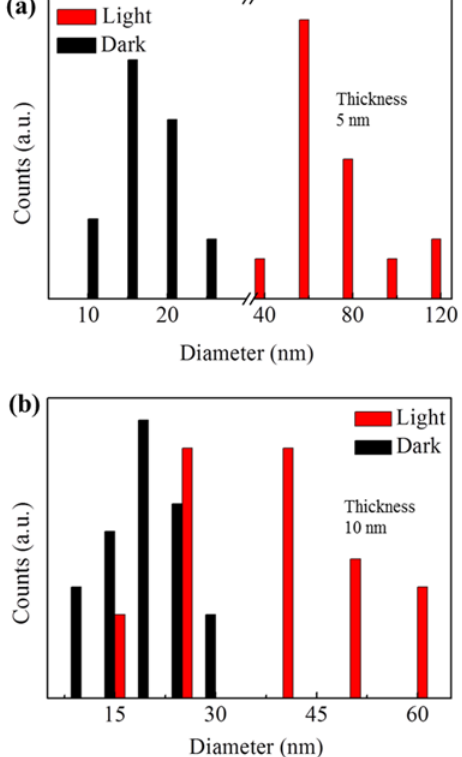
Figure 2. Statistical results of the diameters of Ag nanoparticles generated by Ag nanofilms with and without light illumination; ( a ) Ag nanofilms with thickness 5 nm; ( b ) Ag nanofilms with thickness 10 nm.